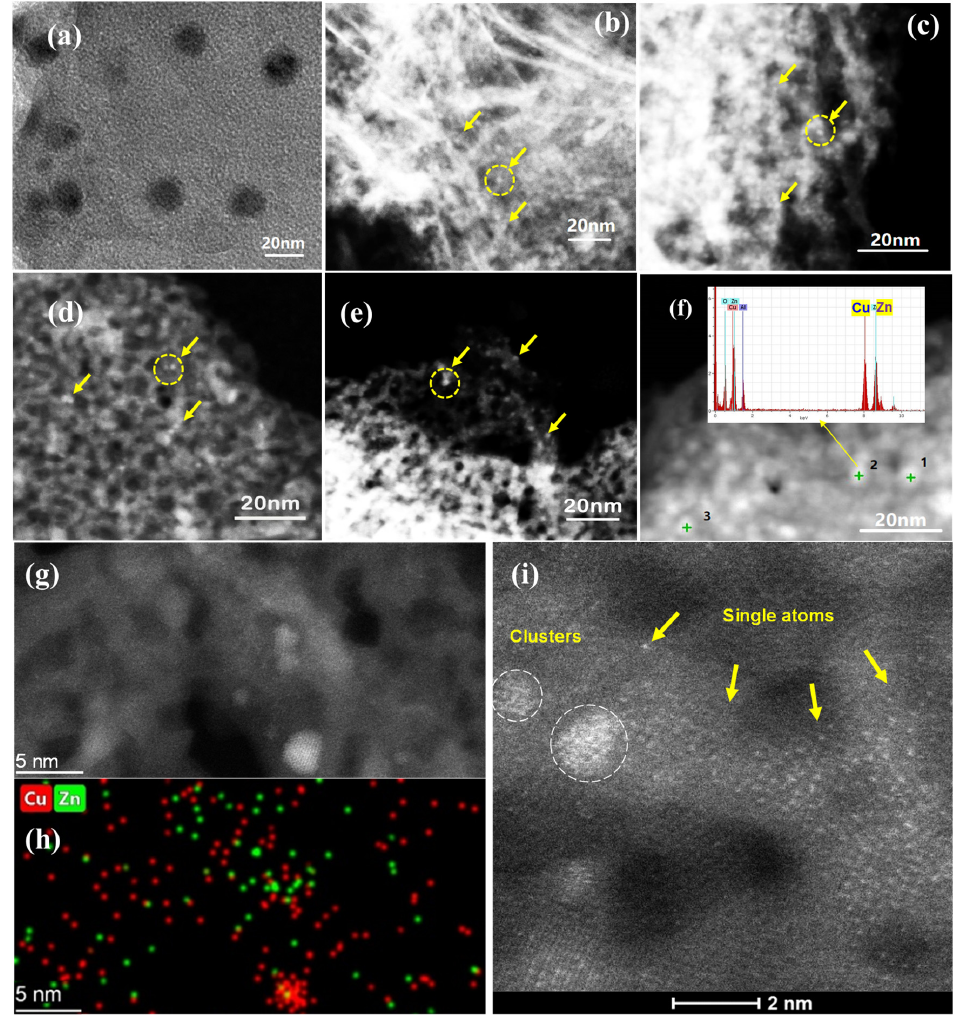
Figure 4. STEM of reduced Cu/CA ( a ), STEM–HAADF of reduced Cu/HA ( b ), Cu1Zn1/HA ( c ), Cu1Zn3/HA ( d , g , i ) and Cu1Zn5/HA ( e ); the EDX dotting ( f ) and mapping ( h ) of a Cu1Zn3/HA